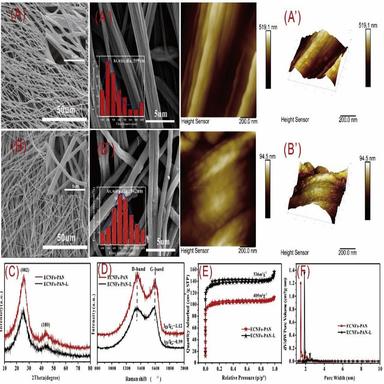
(A): morphology study by SEM of PAN nanofiber; (A') morphology study of ECNFs-PAN by SEM and AFM; (B): morphology study by SEM of ECNFs-PAN-L; (B') morphology study of ECNFs-PAN-L carbon nanofibers by SEM and AFM; (C) XRD spectra; (D) Raman spectra; (E) N2 adsorption–desorption isotherm and (F) PSD of the ECNFs-PAN and ECNFs-PAN-L.